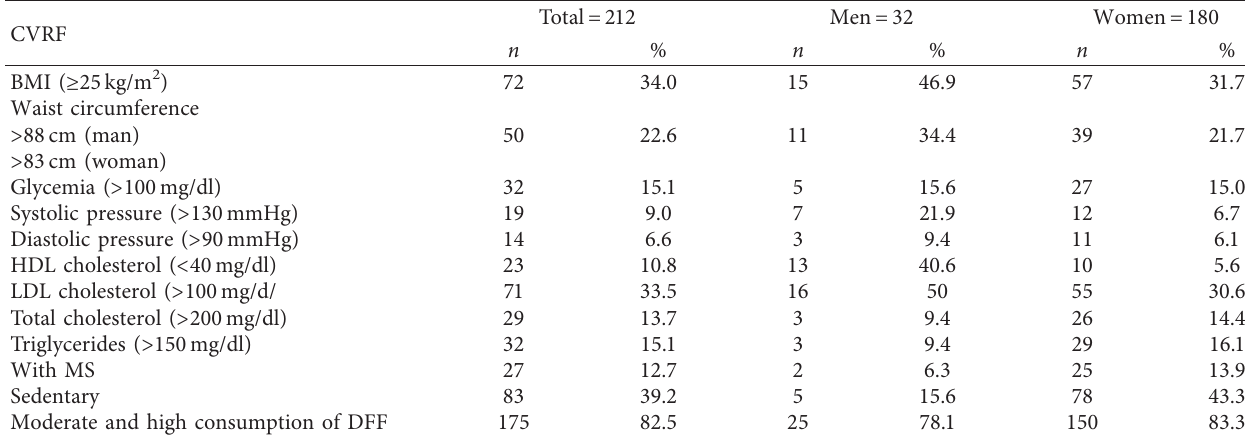
Table 3: The prevalence of elevated values of CVRF according to gender.